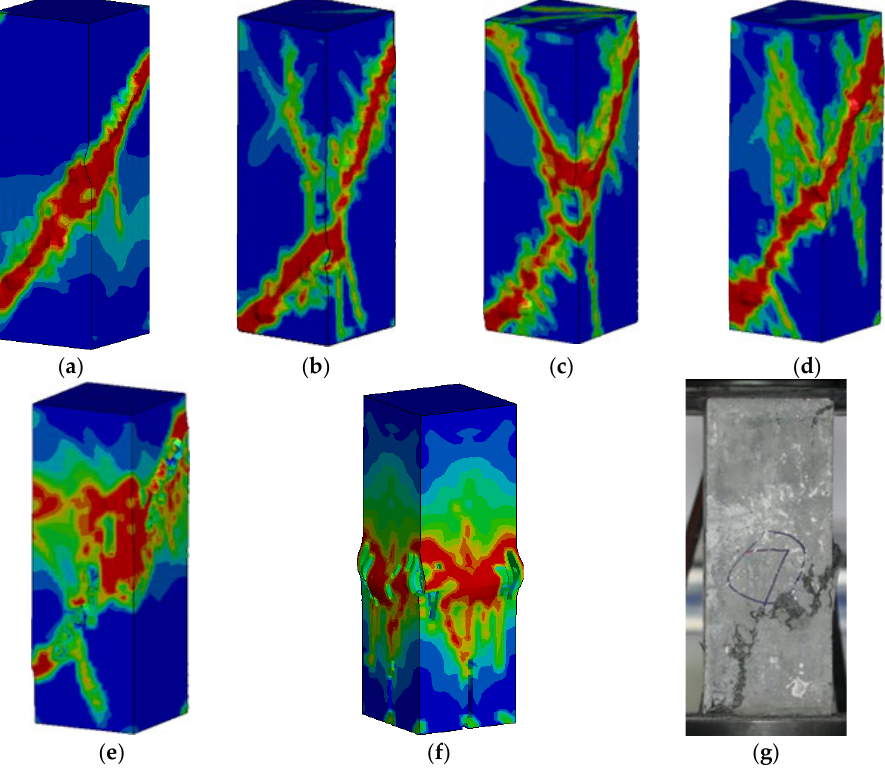
Figure 12. Failure mode of specimens: ( a ) n = 1; ( b ) n = 3; ( c ) n = 4; ( d ) n = 5; ( e ) n = 6; ( f ) n = 7; ( g ) n = 8.